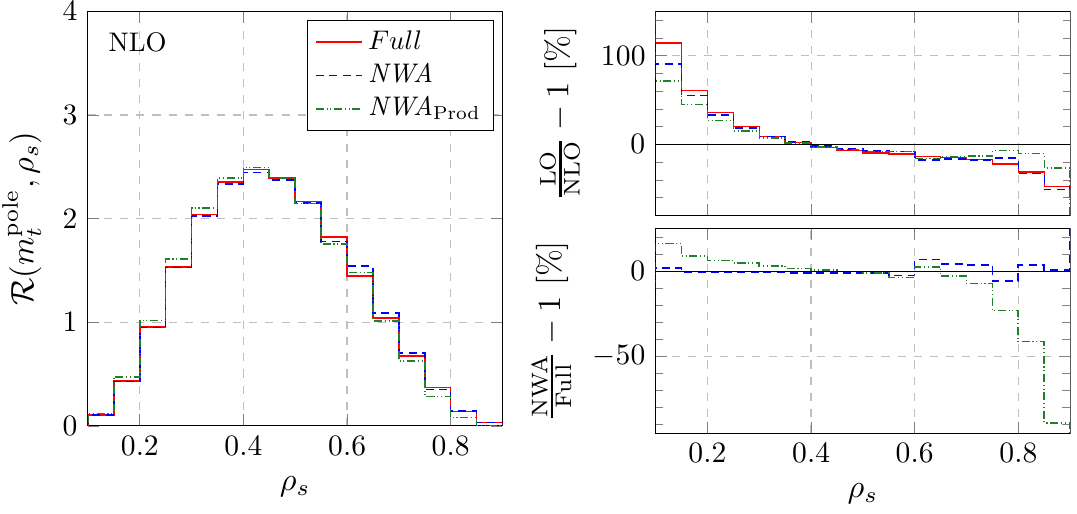
(cid:22) bj + X + (cid:23) e (cid:22) (cid:0) (cid:22) (cid:23) (cid:22) b